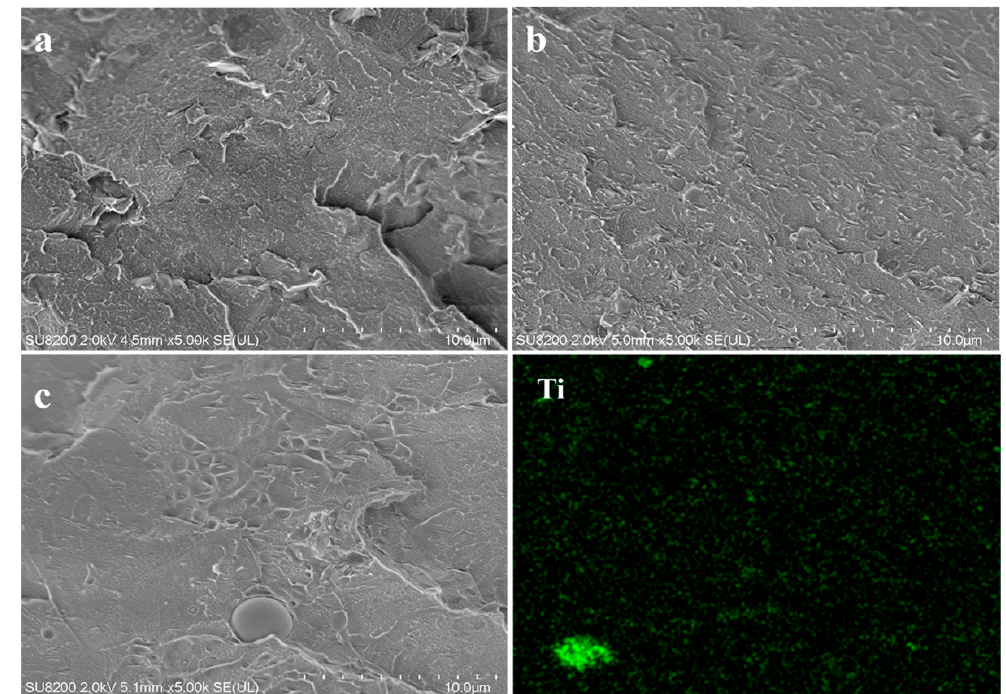
Figure. 3. SEM images of the fracture surfaces for ( a ) polystyrene (PS)/DTAB-Ti 3 C 2 , ( b ) PS/OTAB- Figure 3. SEM images of the fracture surfaces for ( a ) polystyrene (PS) / DTAB-Ti 3 C 2 , ( b ) PS / OTAB-Ti 3 C 2 , Ti 3 C 2 , ( c ) PS/DDAB-Ti 3 C 2 and ( d ) the Ti element mapping of the fracture surface for PS/DDAB-Ti 3 C 2 . ( c ) PS / DDAB-Ti 3 C 2 and ( d ) the Ti element mapping of the fracture surface for PS / DDAB-Ti 3 C 2